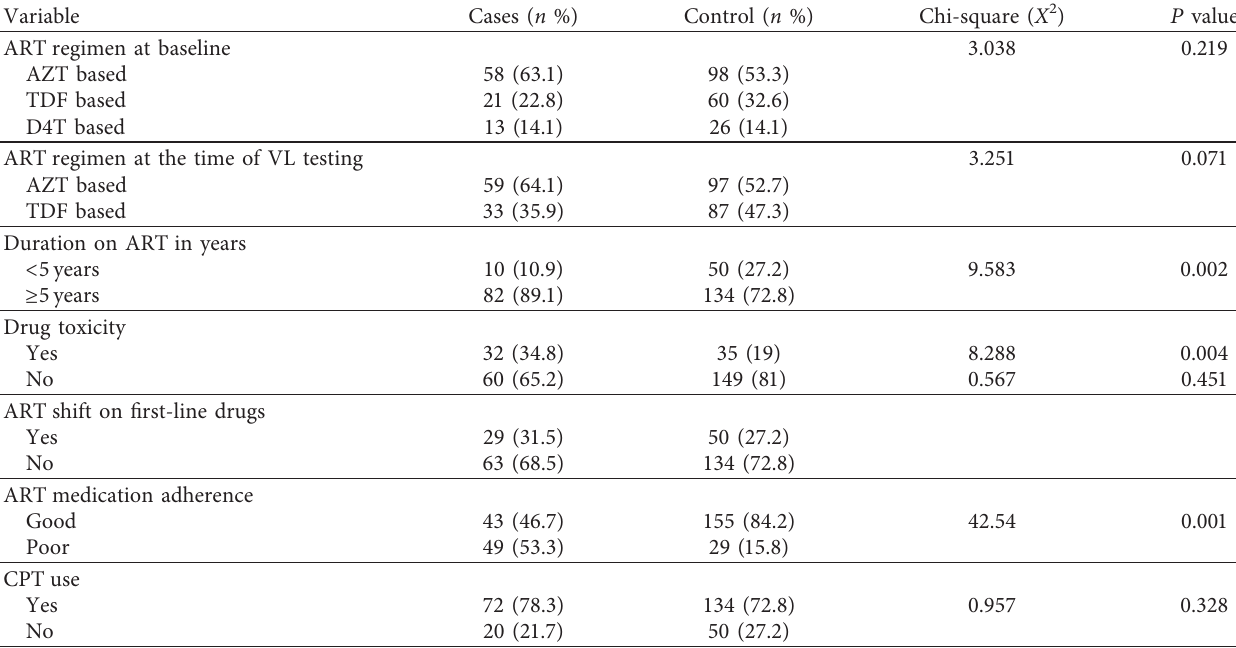
Table 3: Medication-related factors on ARTclients at Waghimra zone health institution ARTclinic, Northern Ethiopia, in 2019 ( n � 276). Variable